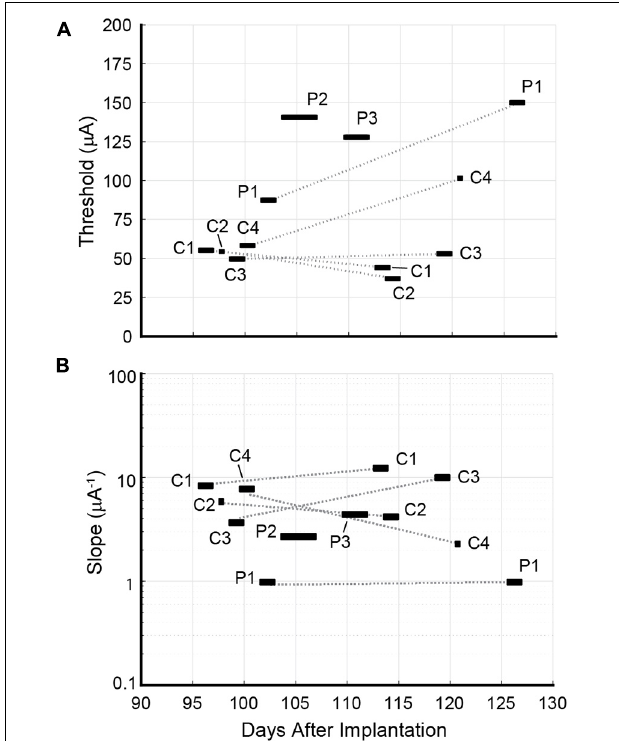
FIGURE 9 | Longitudinal development of (A) detection thresholds x T and (B) slopes ψ (cid:48) ( x T ) for Rat D. Psychometric data for individual channels C1, C2, C3, C4, and P1 were calculated using behavioral data gathered at two timepoints spaced 3 weeks apart. The rat’s waning performance beyond 127 days post-implantation precluded a 2nd round of data collection for channels P2 and P3. Detection thresholds for channels C1 and C2 remained steady or decreased slightly across timepoints. C3’s detection threshold rose slightly. Detection thresholds for C4 and P1 increased dramatically. No pattern was discerned for the longitudinal development of